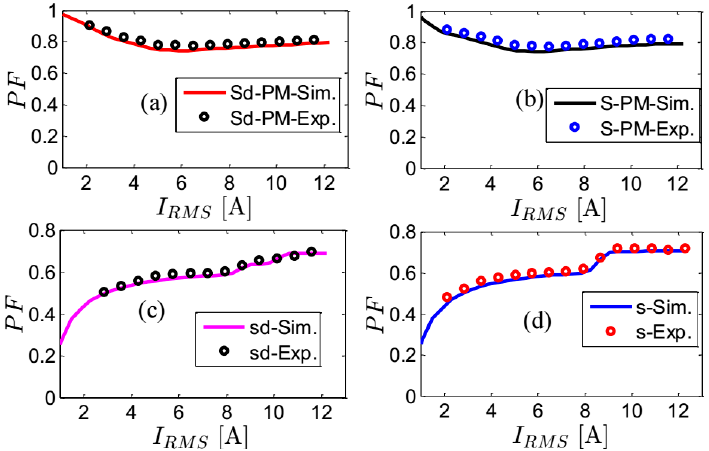
Figure 23. SynRM power factor ( PF ) as a function of stator current ( RMS ) at the optimal current angles and rated speed. ( a ) Sd-PM; ( b ) S-PM; ( c ) Sd; ( d ) S.